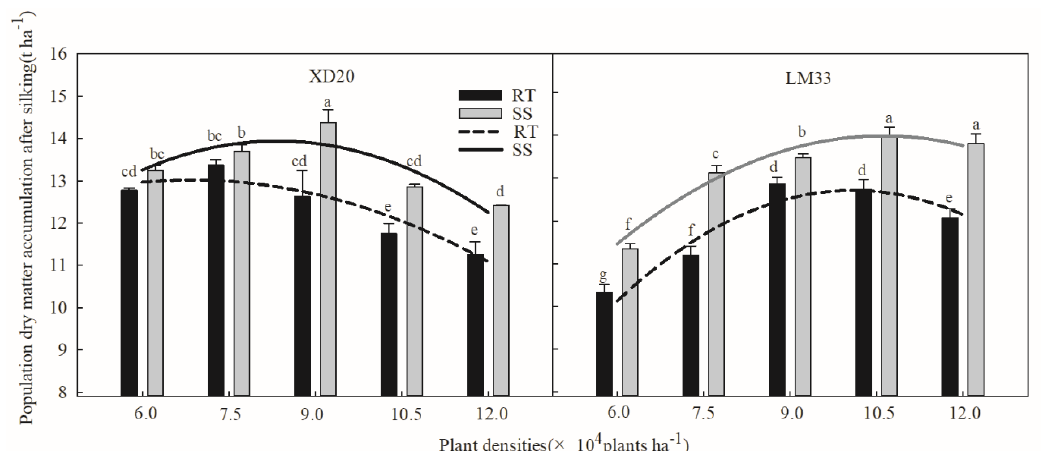
Figure 6. Accumulation of dry matter by high-yielding spring maize under different cultivation methods and planting densities. Different letters on the graph indicate significant differences at p < 0.05.